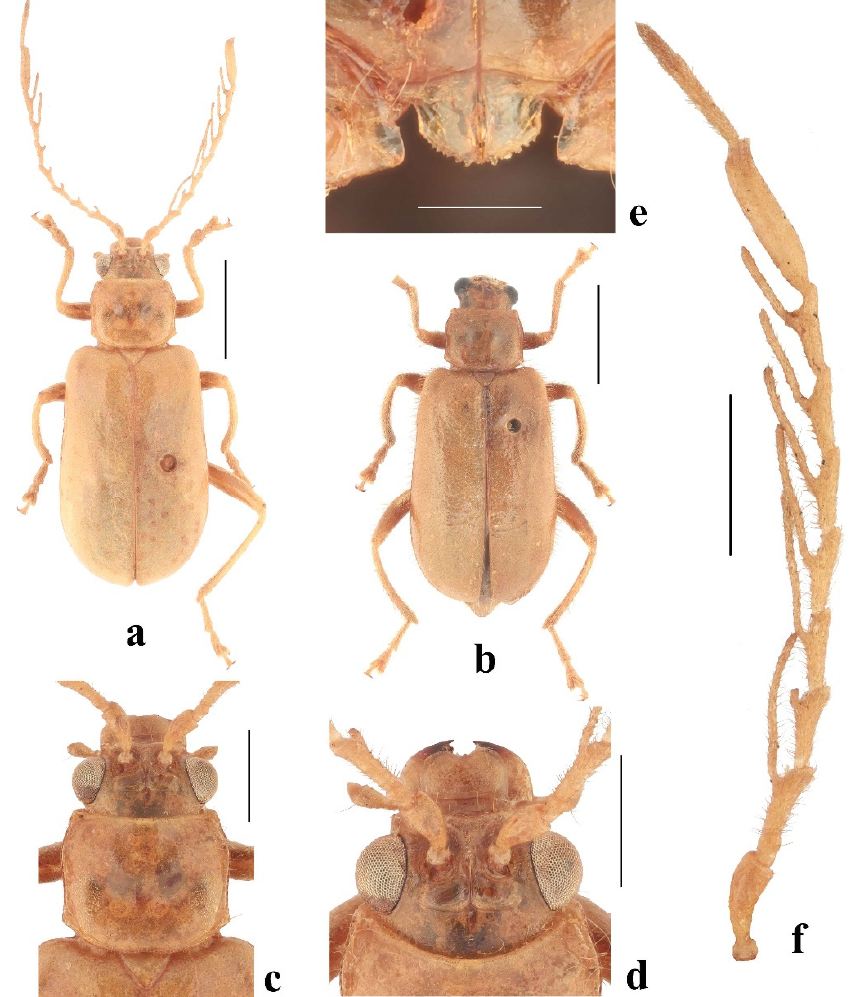
Figure 10. Taumacera unicolor (Jacoby, 1887): ( a ) male; ( b ) female; ( c ) head and pronotum, dorsal view; ( d ) head, frontal view; ( e ) male metasternal process; ( f ) right antenna. (Scale bars: ( a , b ) = 2 mm, ( c , d , f ) = 1 mm, ( e ) = 0.3 mm).